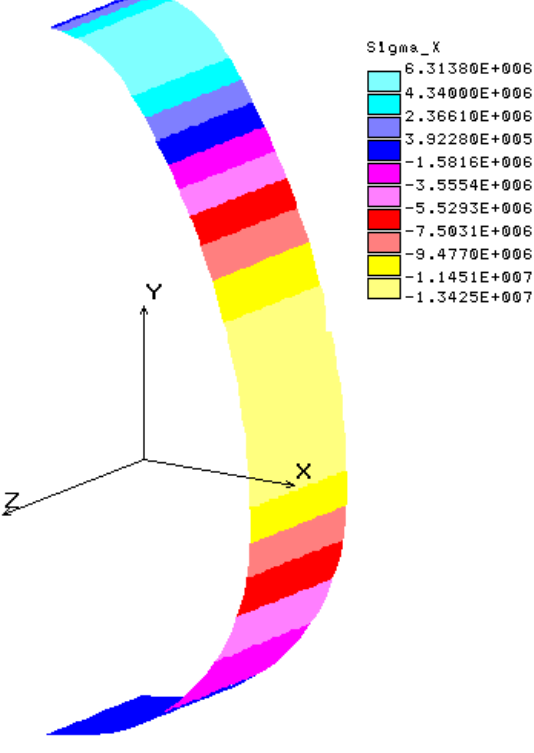
Figure 7: Diagram of normal stresses, wall thickness equal to 12 mm, load scheme 1.